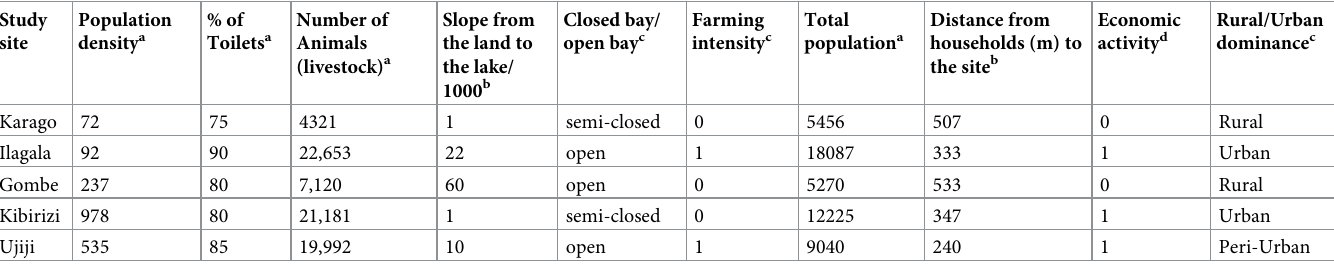
Table 2. Characteristics of the five study